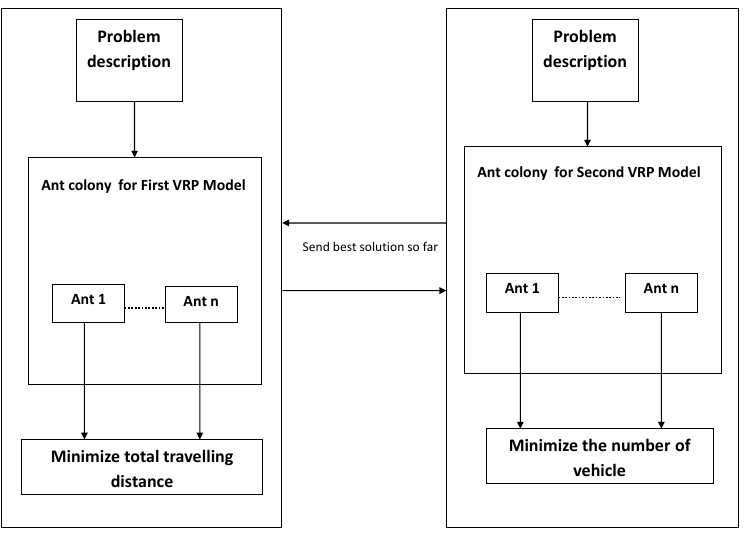
Figure 2. Model dependency